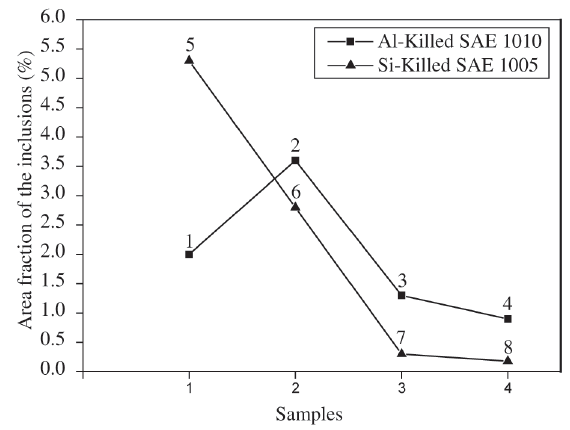
Figure 4. Area fraction of the inclusions in the samples of the SAE 1010 and 1005